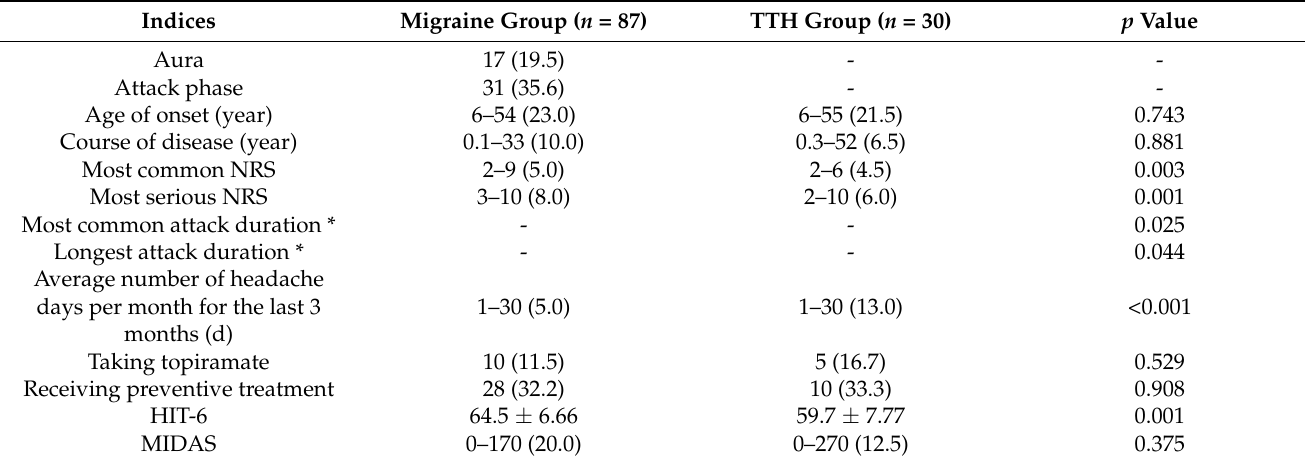
Table 2. Headache characteristics and headache-related disability in the migraine and TTH groups.